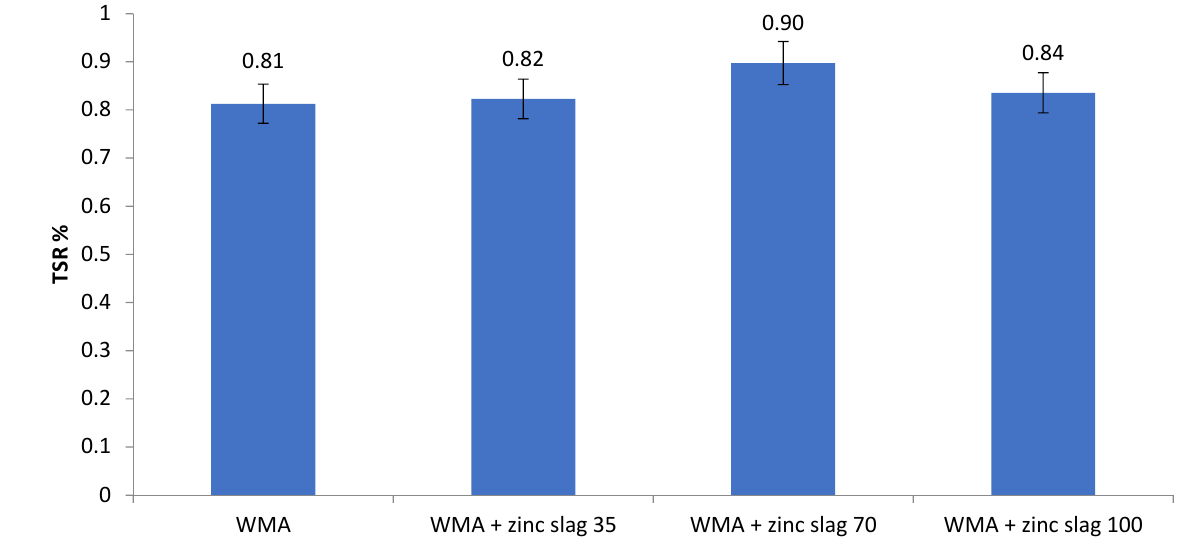
Figure 8. TSR values for asphalt samples.